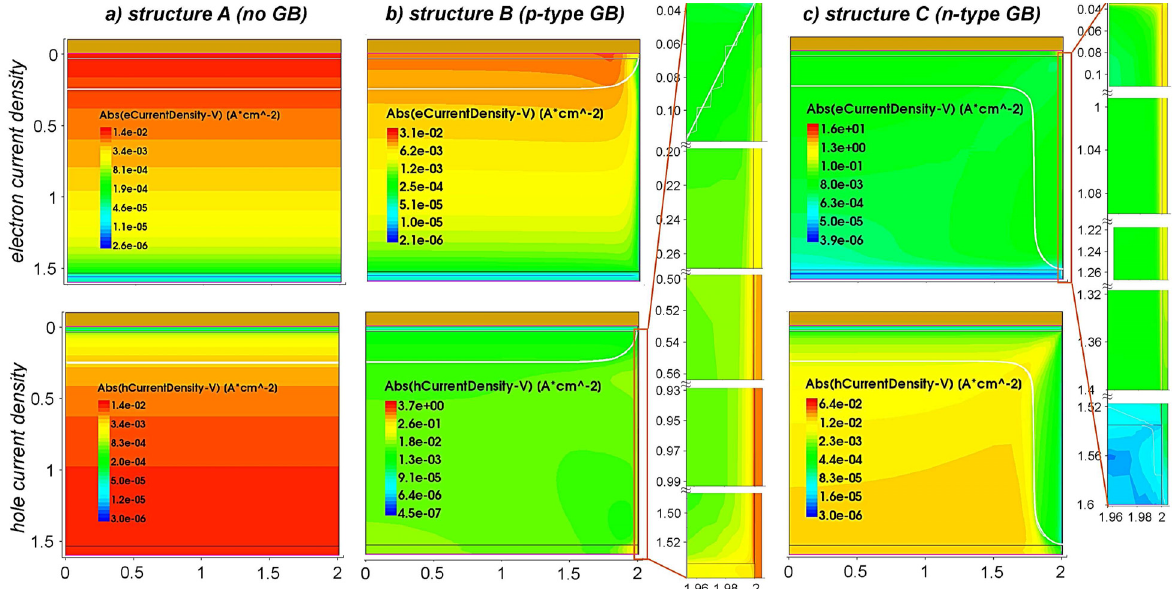
Fig. 5. Exemplary 2D simulations of the electron and hole current density distributions in the cell at short circuit conditions for (a) structure A, (b) structure B and (c) structure C. The GB doping concentration is 10 20 cm − 3 and the GB defect density 10 16 cm − 3 eV − 1 . The boundary of the space charge region is marked with a white line. The zoom-in into the GB layer shows the extremely high majority-carrier current in the GB increasing towards the respective majority carrier contacts.